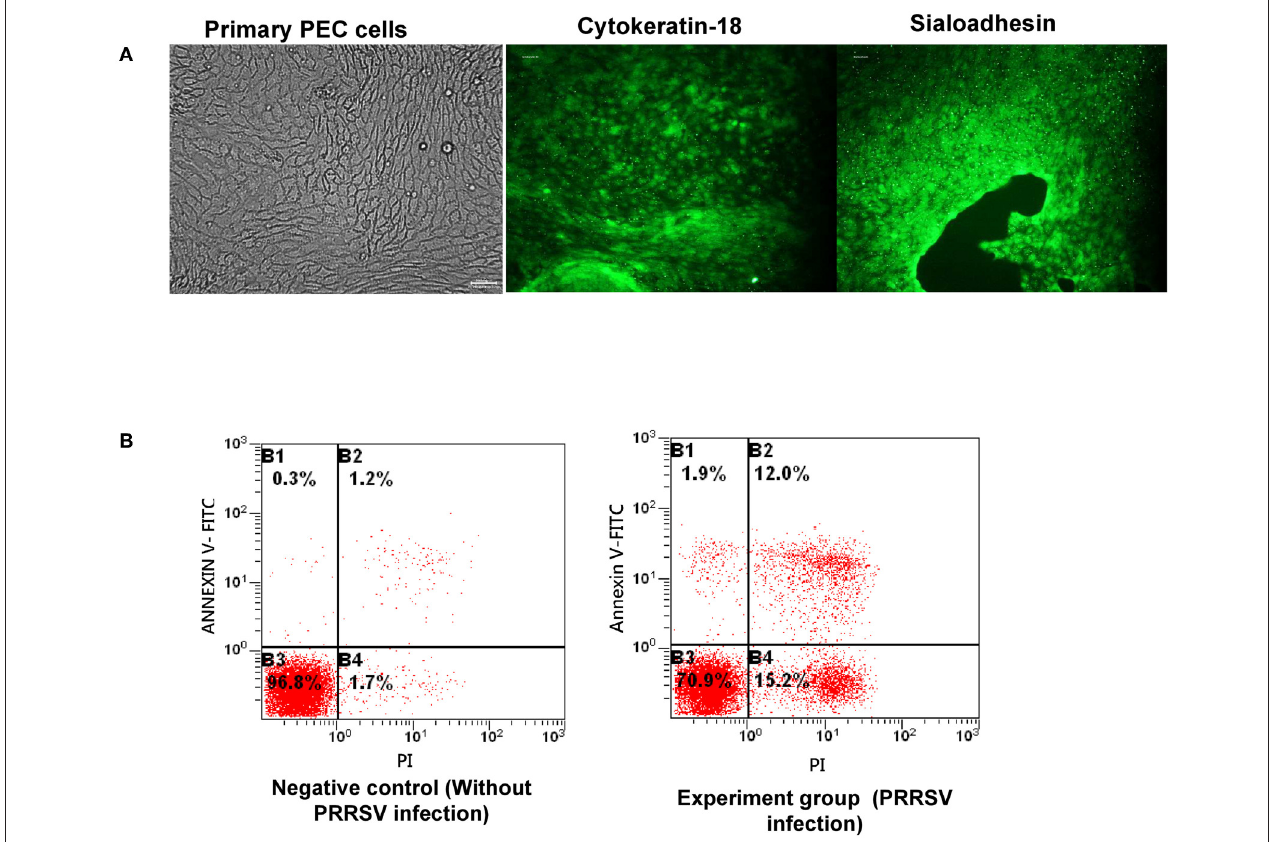
FIGURE 1 | Isolation and purification of PECs and infection capacity evaluation. (A) Isolation and verification of PECs by immunofluorescence. The left image represents isolated PECs from the uterus. The middle image illustrates expression of the cytokeratin-18 marker in PECs. The right image illustrates expression of the sialoadhesin marker in PECs. (B) Apoptosis ratio analysis of PECs infected with PRRSV (MOI 10:1). The left image shows PECs without PRRSV infection. The right image shows PECs infected with PRRSV (MOI 10:1).